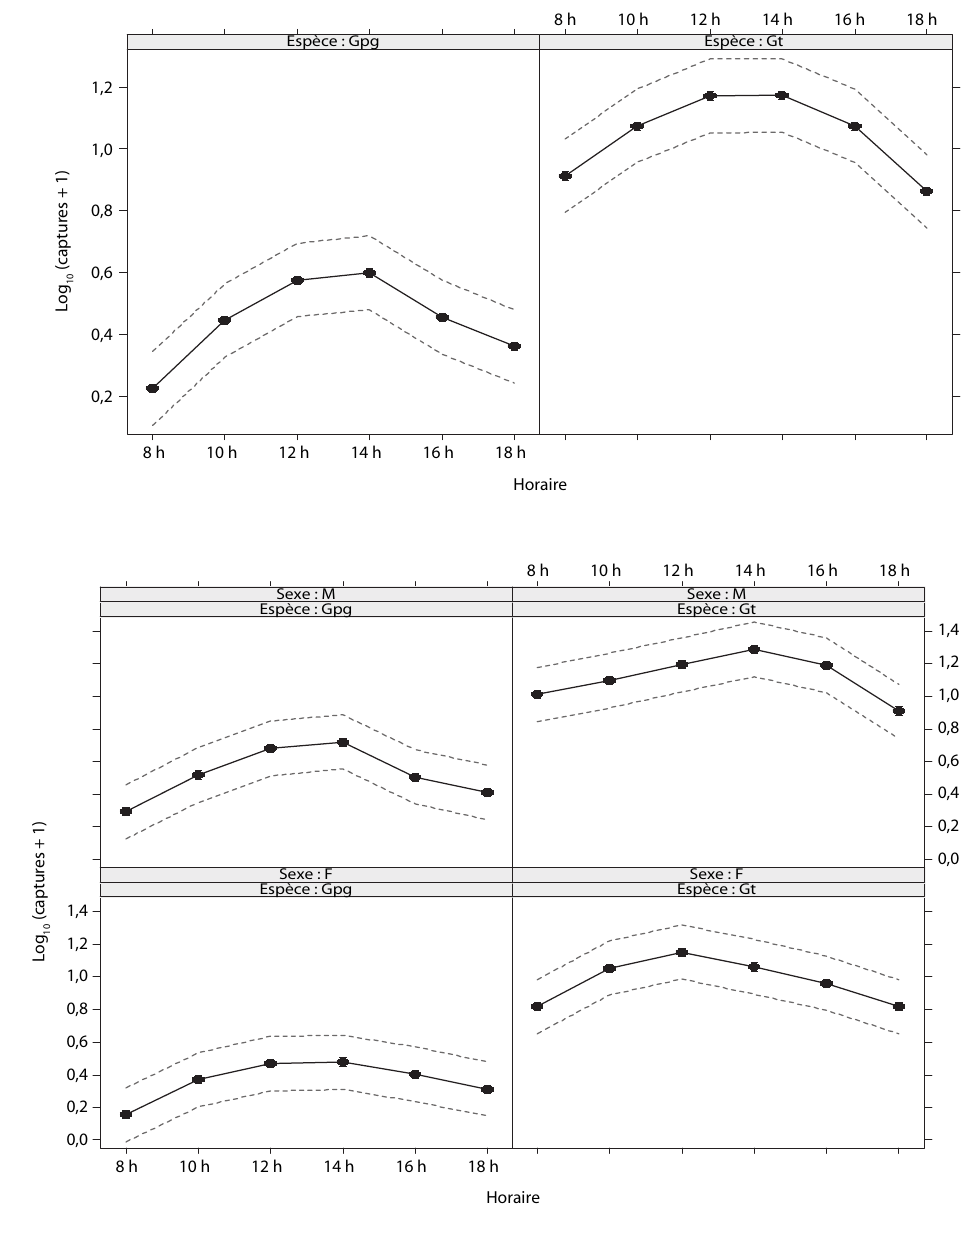
Figure 4. – Profils de l’activité journalière de G. tachinoides et G. p. gambiensis à Folonzo.